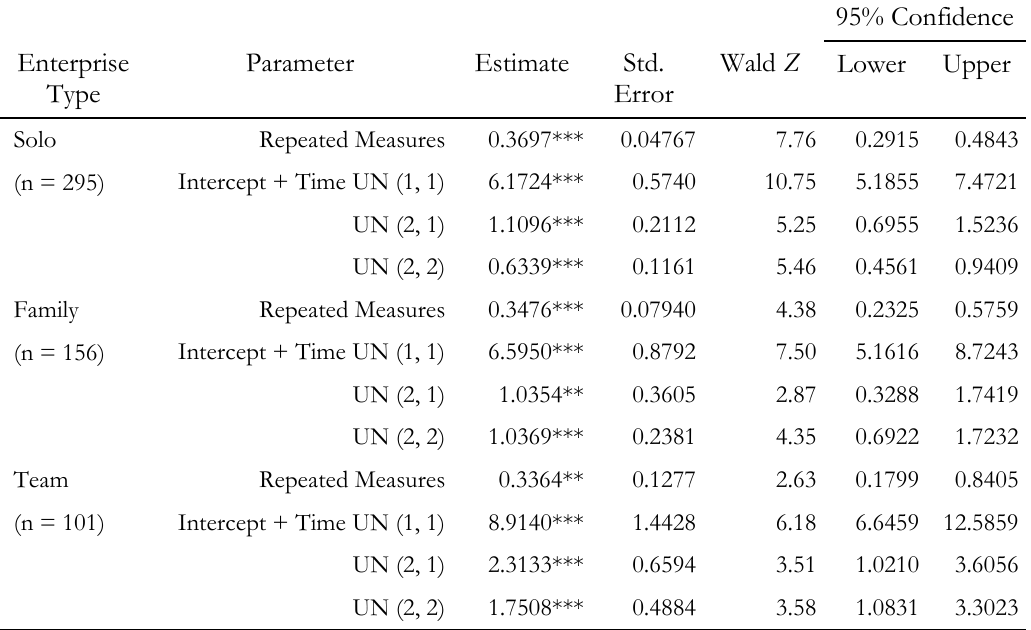
Table 3. Estimates of Covariance including Time